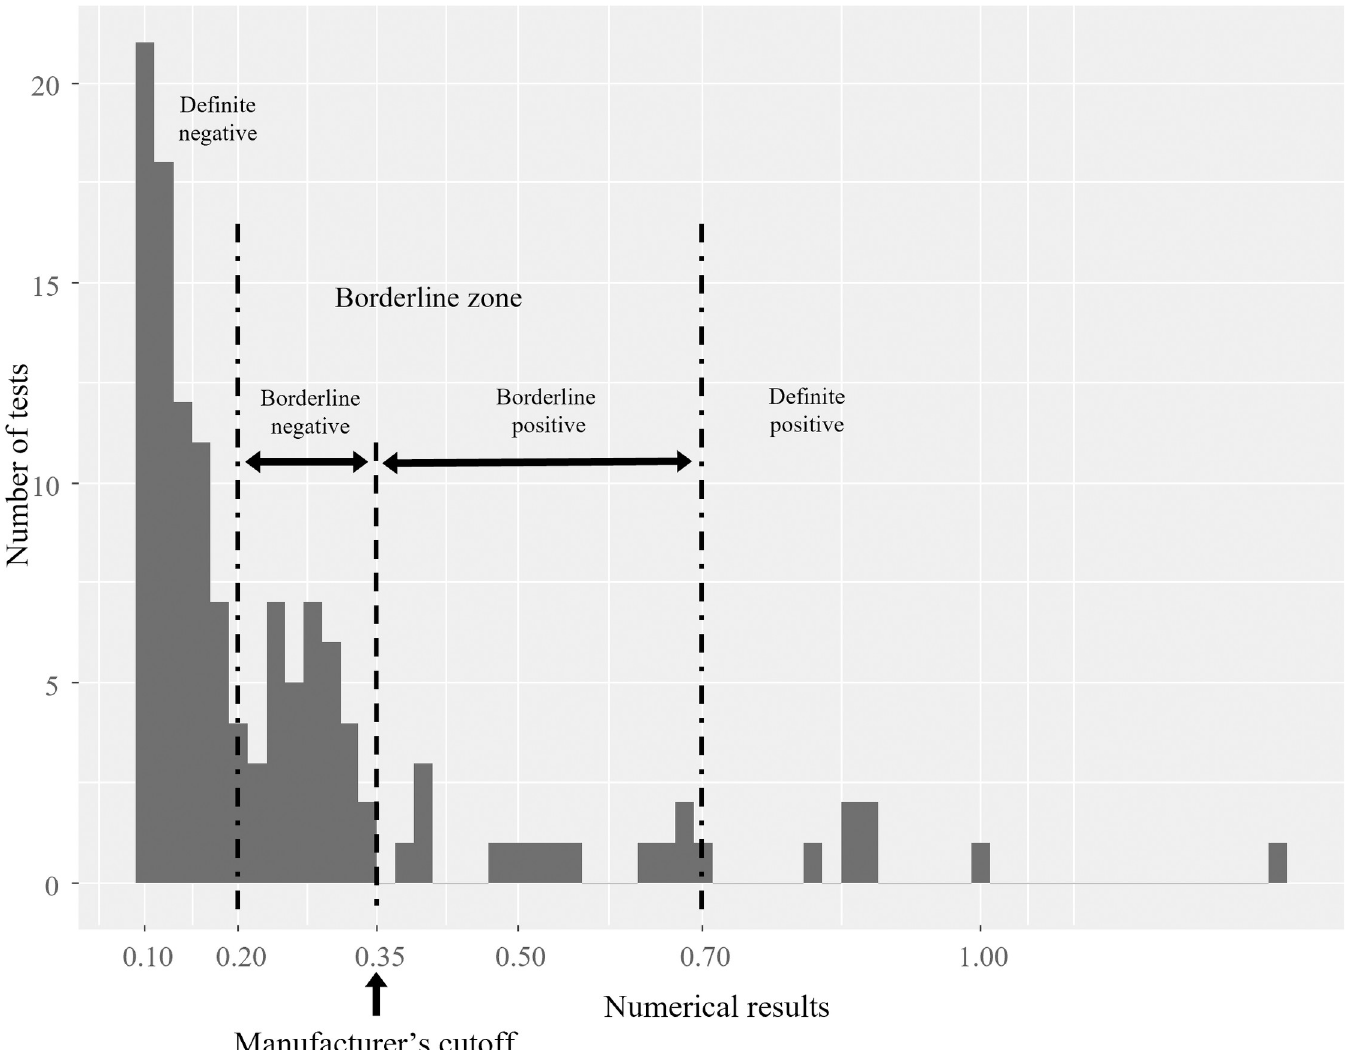
Fig 2. QFT-GIT results ( � 0.1 to < 1.4 IU/mL) of 477 HCWs with follow-up (n = 128). Abbreviations: QFT-GIT, QuantiFERON-TB Gold In-Tube; HCW, healthcare worker. Among 1,191 results of 477 HCWs, 1,040 results with < 0.1 IU/mL, 18 results with 1.4 > IU/mL and 5 indeterminate results were not shown in the figure. https://doi.org/10.1371/journal.pone.0235254.g002 Table 3. Interpretation of serial QFT-GIT results (714 time points, 477 HCWs). Manufacturer’s cutoff Borderline zone By time points By HCWs By time points By HCWs Stationary 676 (94.7) 441